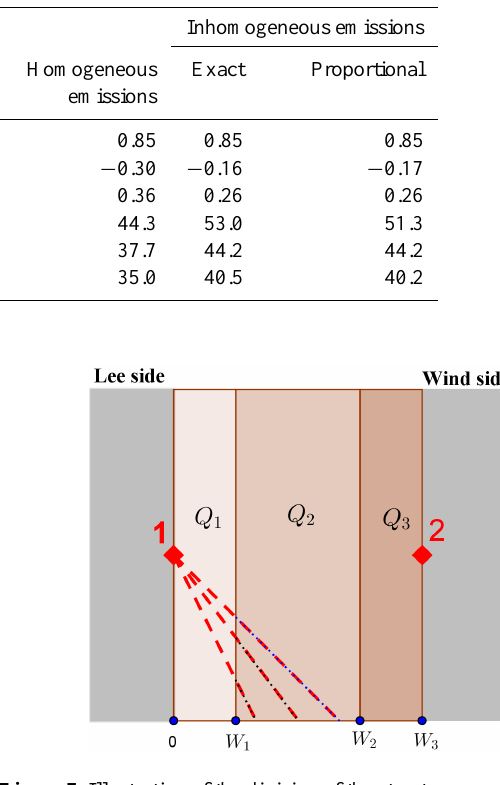
Figure 7. Illustration of the division of the street canyon into a num- ber of segments with accumulated widths W 1 , W 2 , W 3 , etc. and emission strengths Q 1 , Q 2 , Q 3 , etc. The red dotted lines represent the integration path for receptor 1 for different wind directions. The blue dotted lines represent the contribution from segment Q 2